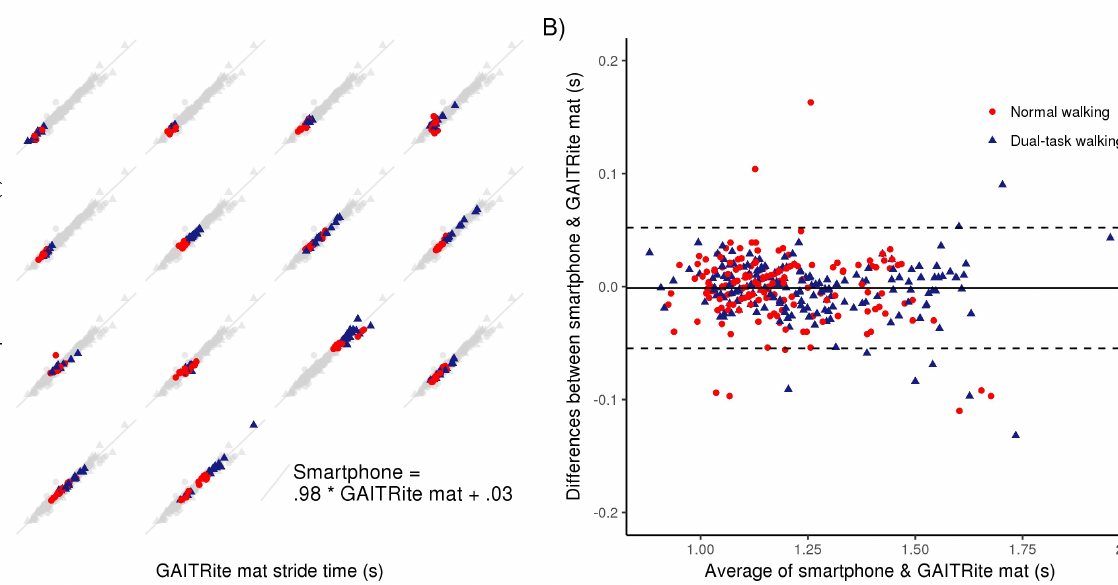
Figure 5. Correlation and agreement between stride times derived from a smartphone placed in the pocket and a GAITRite mat. (A) The timing of each individual stride that occurred over the GAITRite mat during all trials of normal and dual-task walking over 2 visits are presented separately for each participant. Stride times were noticeably longer during dual-task walking than during normal walking, for multiple participants. The gray background plot in each subplot is the same and represents the entire sample of stride times. Stride times derived from the app and the GAITRite mat were strongly correlated with one another ( r 2 =.98, P <.001). The orthogonal best fit line of this entire sample had a slope of approximately 1 and an intercept of approximately 0. (B) Bland-Altman scatterplot depicting the difference (error) in measured time, as a function of the average time, for each stride as derived from the app and GAITRite